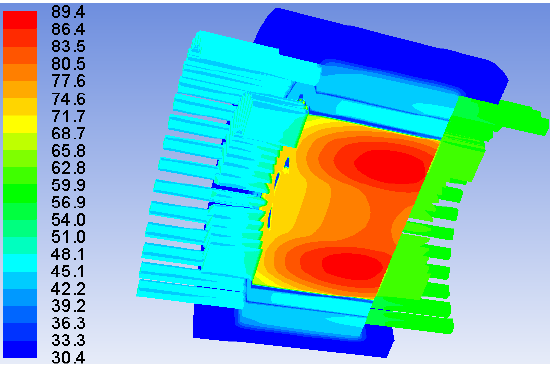
Figure 13. Thermal field distribution under condition of water cooling used in the casing and axial forced air when both the SM and the DRM are running at the rated speed and rated load.